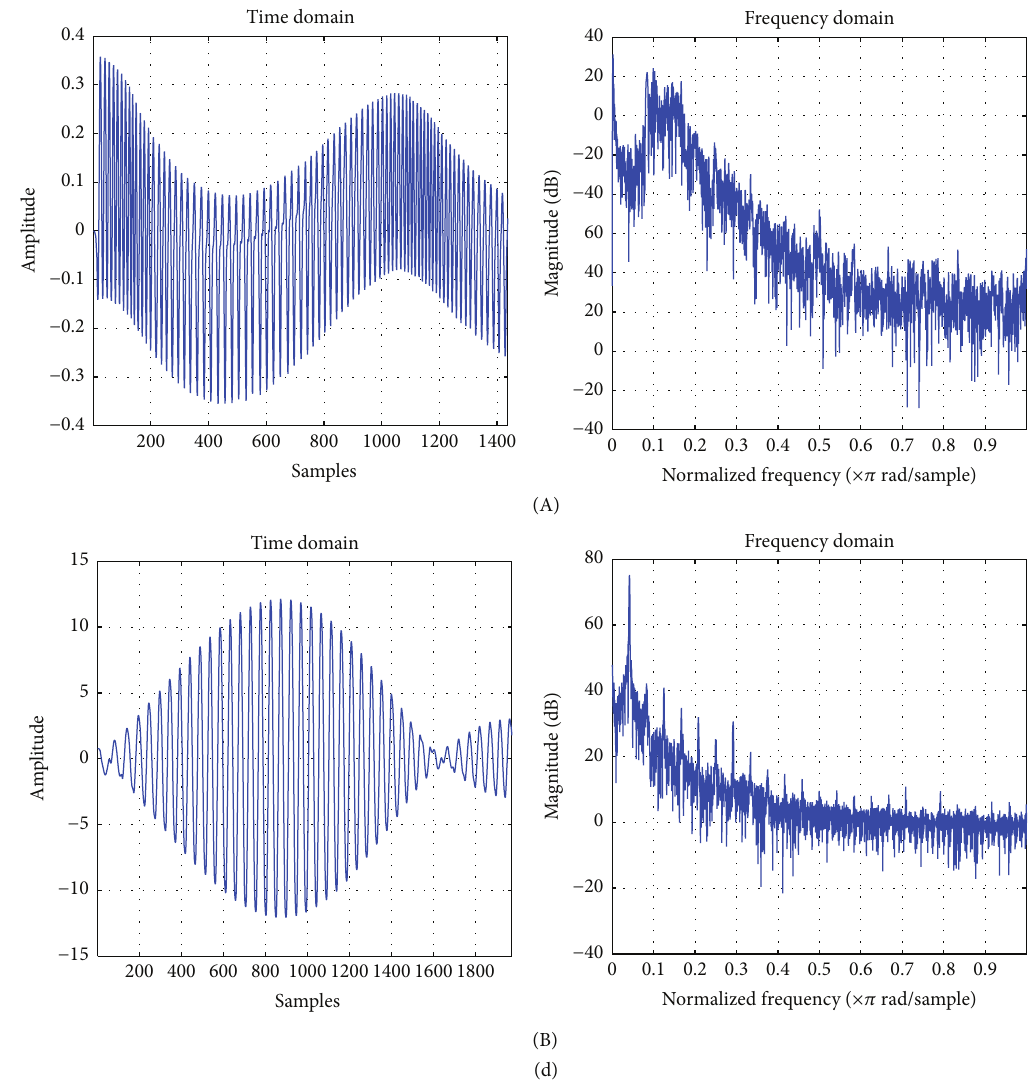
Figure 6: Logarithmic amplitude spectrum comparisons of cracked rotor and uncracked rotor near its critical speed with different mass eccentricity: (a) 𝜀 = 0 . 001; (b) 𝜀 = 0 . 021; (c) 𝜀 = 0 . 042; (d) 𝜀 = 0 . 059, (A) for uncracked rotor; (B) for cracked rotor with parameters 𝑎/𝐷 = 0 . 45, 𝛽 = 𝜋/